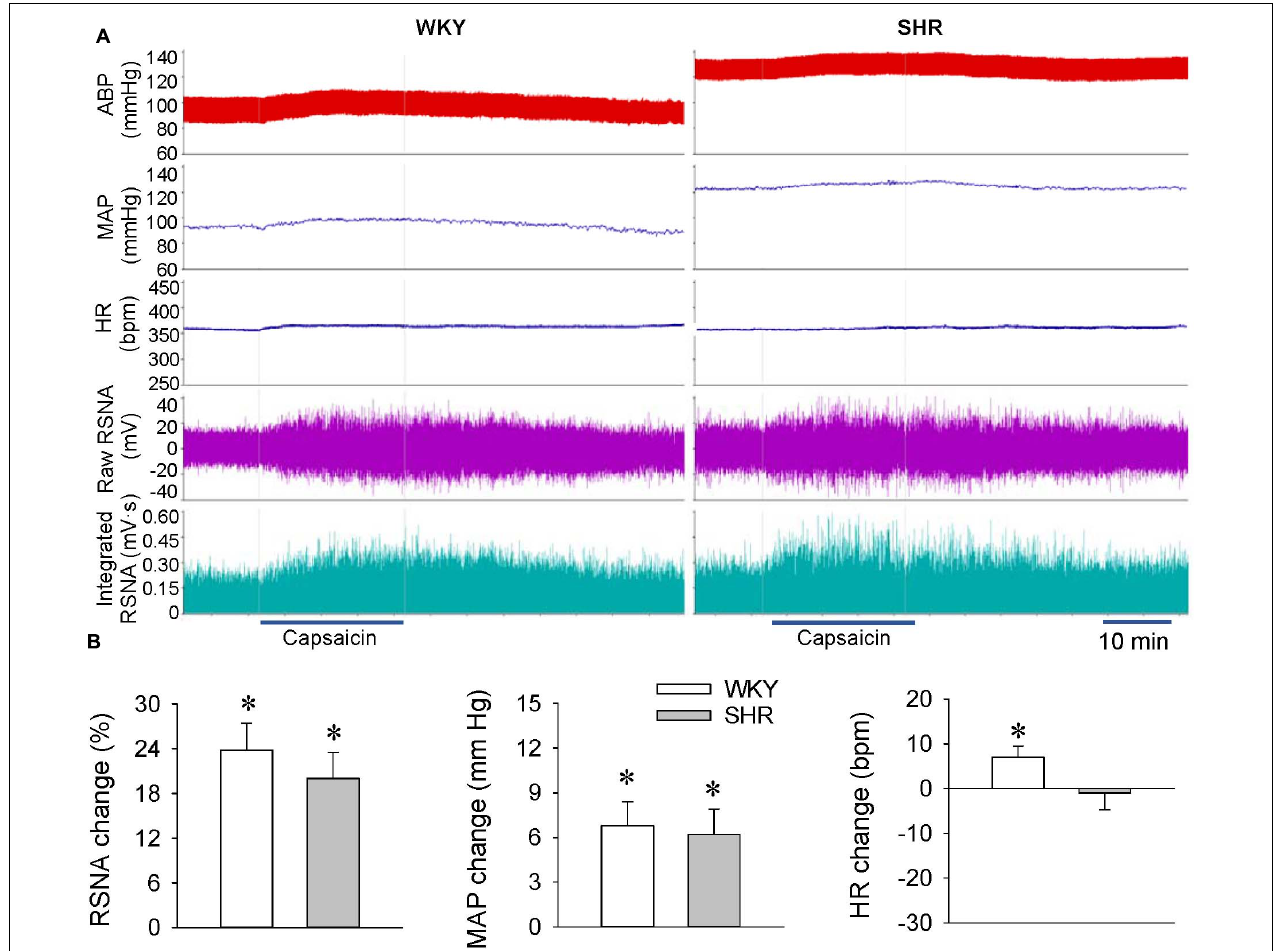
FIGURE 2 | ERR in the WKY and SHR at the age of 12 weeks. The ERR was induced by renal infusion of capsaicin at 1 nmol/min for 20 min. (A) representative recordings showing the recordings of the capsaicin-induced ERR. (B) bar graph showing the capsaicin-induced ERR. Values are mean ± SE. ∗ P < 0.05 vs the values before renal infusion. No significant difference was found between the WKY and SHR. n =